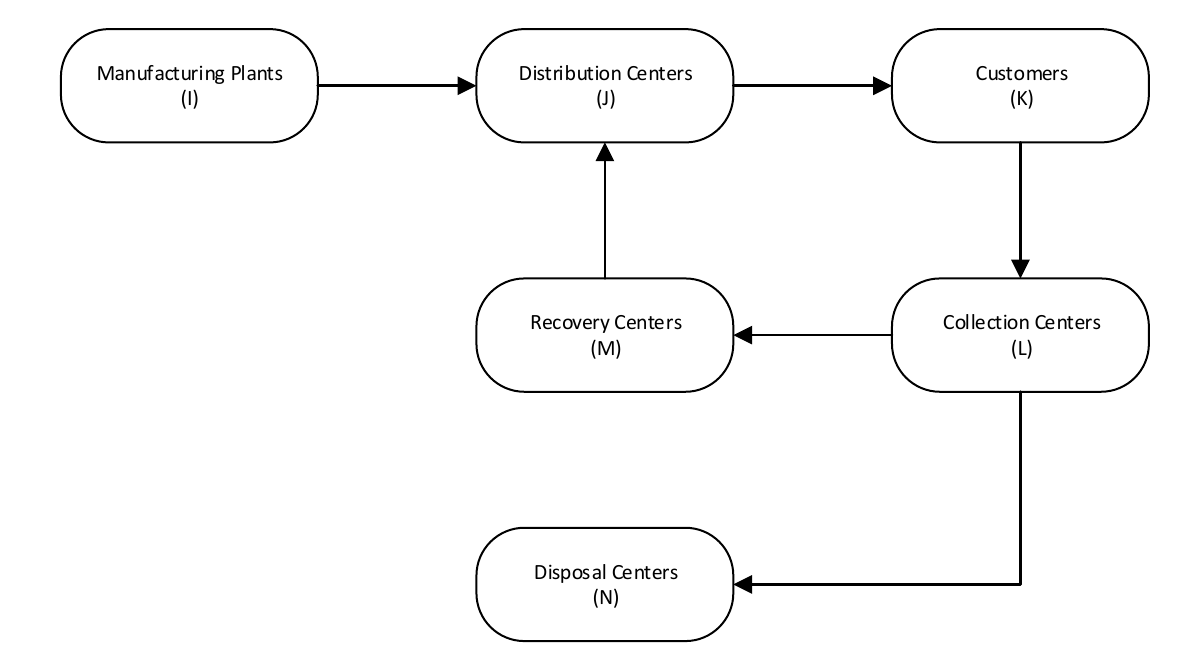
Figure 1. Closed-loop supply chain